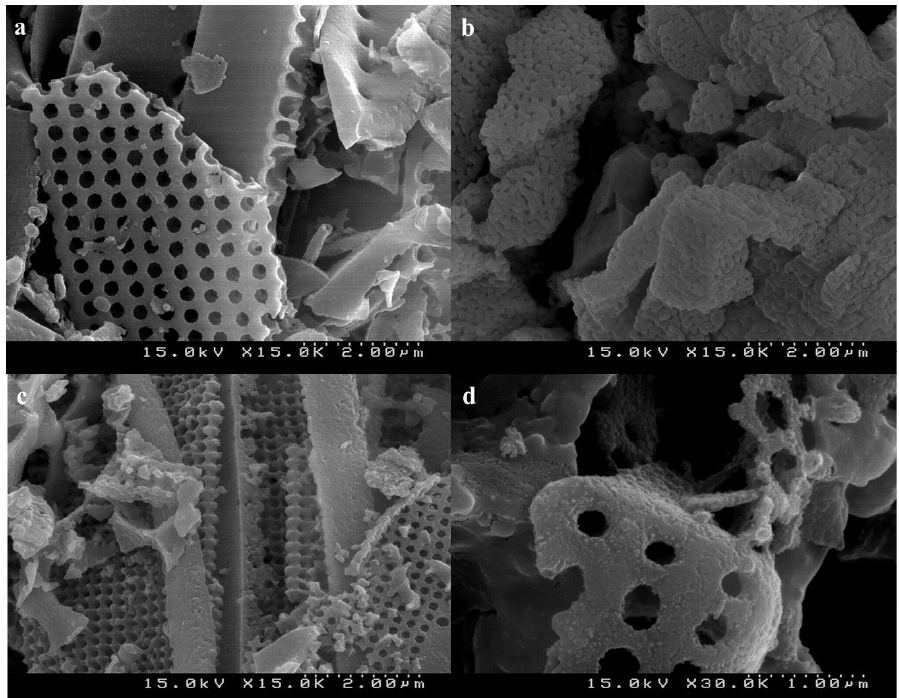
Figure 3. SEM images of natural diatomite ( a ), 6% Eu-doped Y 2 O 3 ( b ) and 6% Eu-doped Y 2 O 3 -coated diatomite at different magnification ( c , d ).